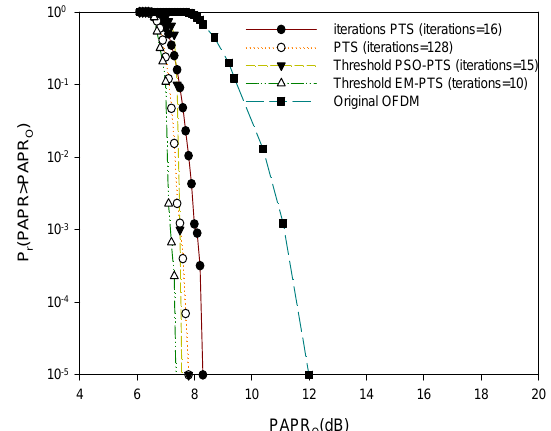
Fig. 5 PTS performance using threshold structured (N =256, V =4).